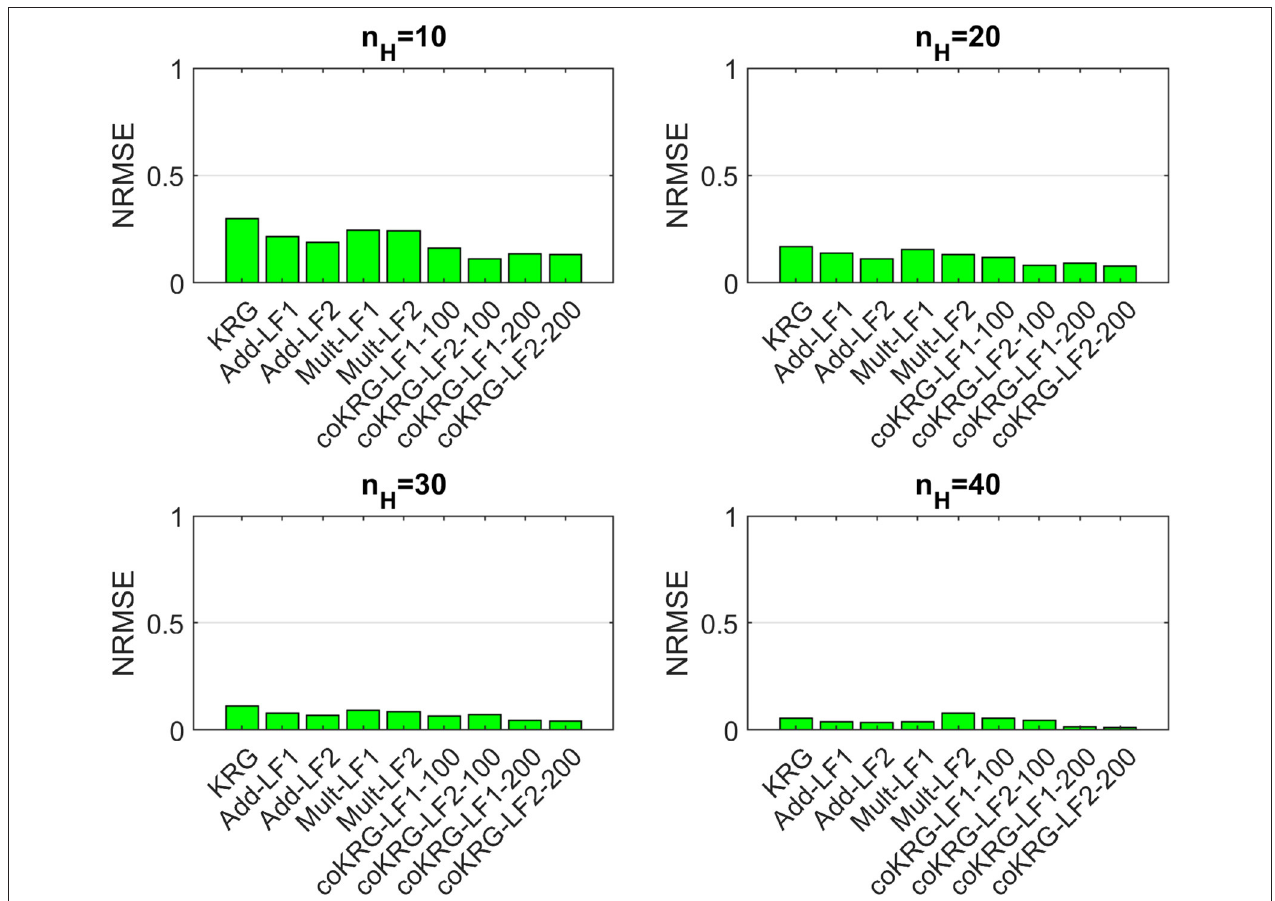
FIGURE 6 | Comparisons of all methods on the average value of the NRMSE performance metric for various training sample